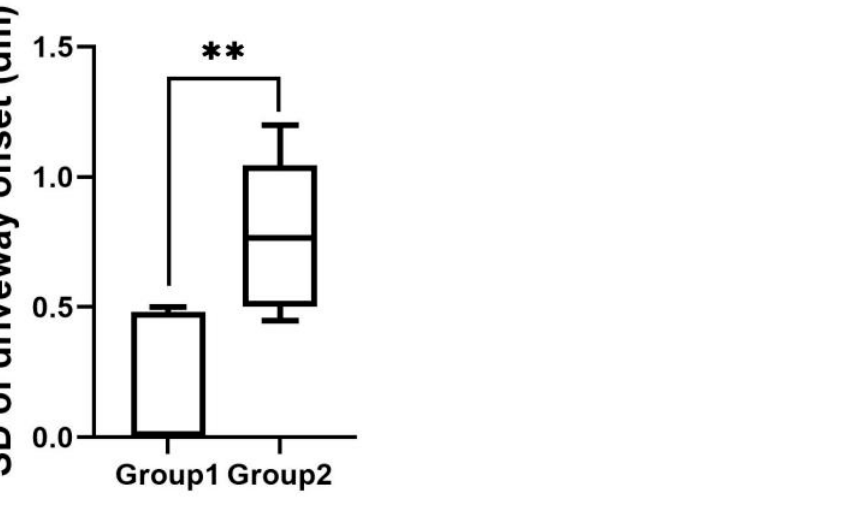
Figure 8. Saccades time and fixation time in telephone task. * indicates significant difference ( p < 0.05). ** indicates significant difference ( p < 0.01). As shown in Figure 9, it can be concluded from the usability scores that the experi- mental group 2 subjects rated the usability of the robot lower (𝑝 = 0.049) . In terms of details, the time required to complete tasks was significantly different between experi- mental groups (𝑝 = 0.01) , while ease of task completion (𝑝 = 0.374) and satisfaction with support information (𝑝 = 0.262) was not significantly different.